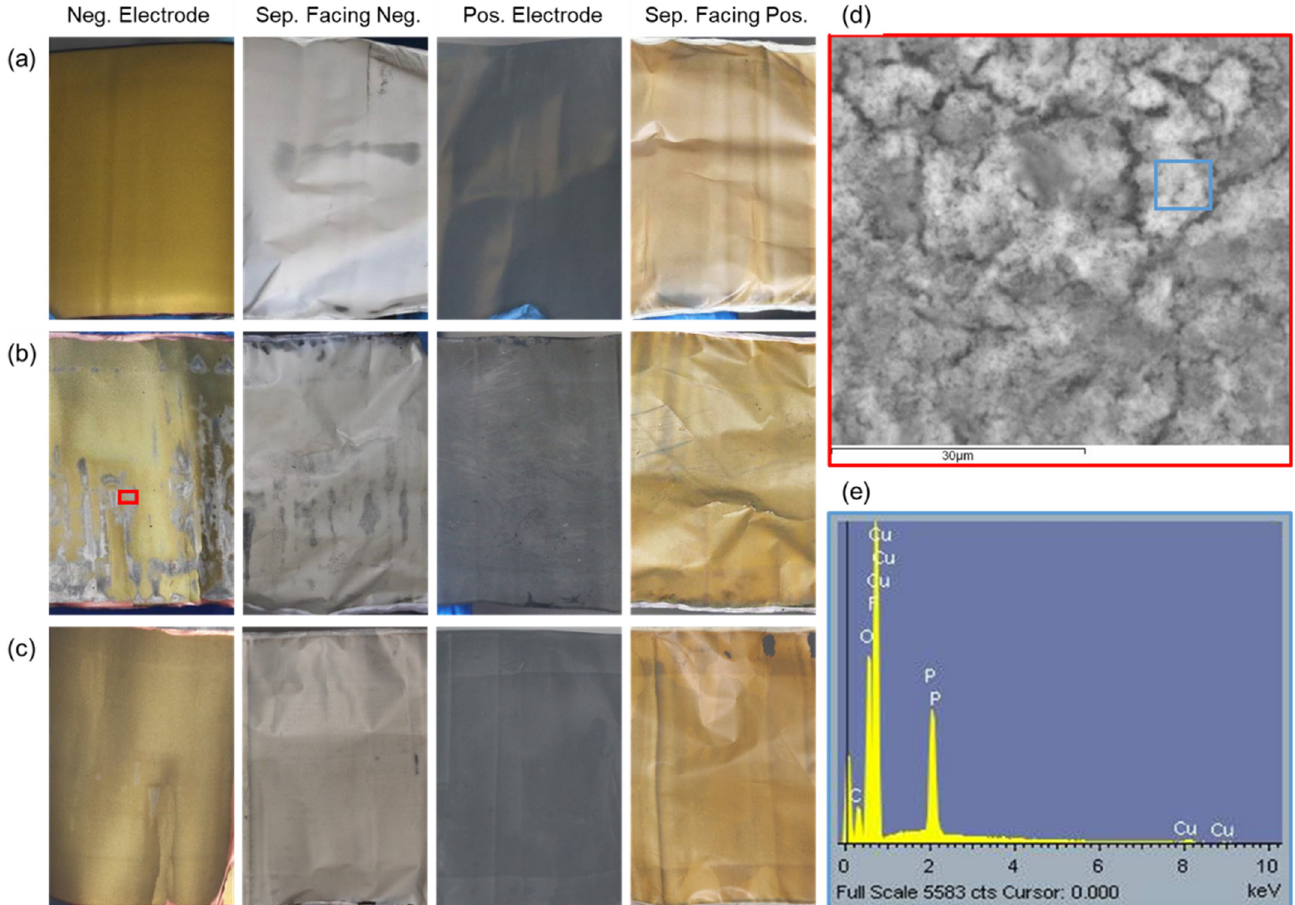
Figure 6. Electrodes and separators of cells after charge. ( a ) New cell. ( b ) Used cell showing low rate triggered ECTR. ( c ) Used cell not exhibiting ECTR. The four images in each panel are representative areas of the negative electrode, separator facing the negative electrode, positive electrode, and separator facing the positive electrode of each cell. ( d ) SEM image of the region observed on the negative electrode in the red box in panel ( b ). ( e ) EDS of the region in the blue box in ( d